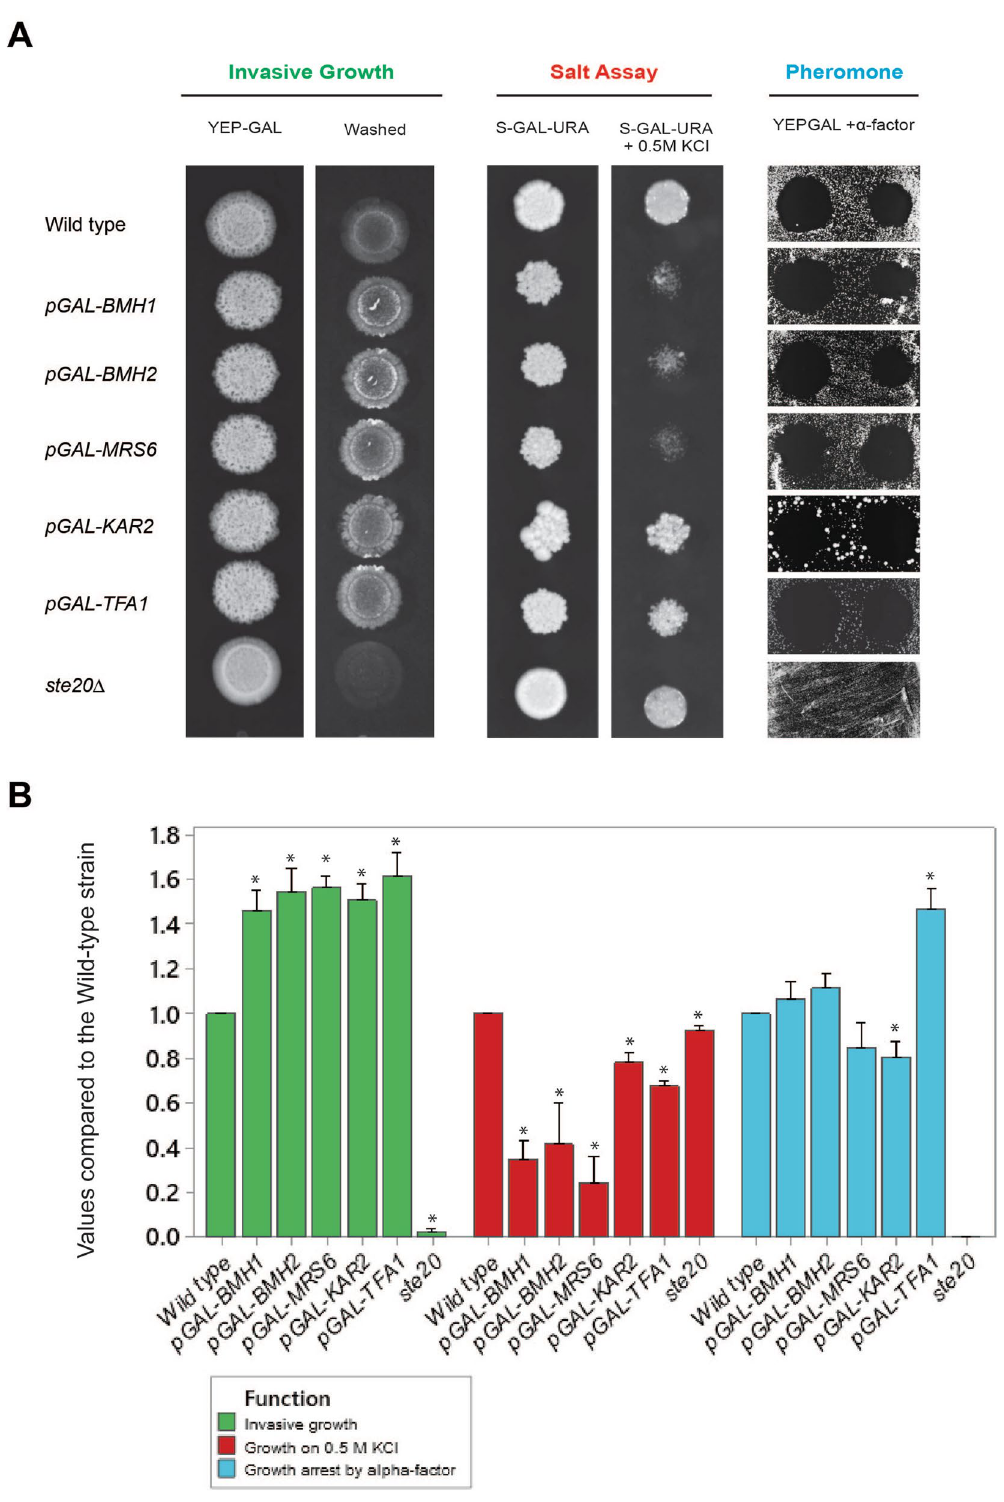
Figure 4. Phenotypic analysis of the role of overexpression of selected candidates on MAPK pathway activity. (A) Wild-type cells (PC6810) containing the indicated plasmids were grown in S-D-URA for 16 h and spotted onto the indicated media. For the PWA, cells were spotted onto YEP-GAL medium for 96 h. The plate was photographed (YEP-GAL), washed in a stream of water, and photographed again (Washed). To assess salt sensitivity, cells were spotted on S-GAL-URA and S-GAL-URA + 0.5 M KCl media for 72 h at 30 °C. To determine sensitivity to α-factor, cells were spread onto S-GAL-URA plates. 10 μl and 3 μl drops of 1 mg/ml α-factor were applied to the plates followed by incubation for 48 h. (B) Plot shows the quantified data for the invasive growth, salt assay, and pheromone. Values normalized to wild type (WT) values, which were set to a value of 1. Bars represent the average of at least three independent experiments. Error bars represent the standard deviation between trials. Asterisks indicate significant differences compared to the wild-type strain for the same condition (p-value < 0.01 by Student’s